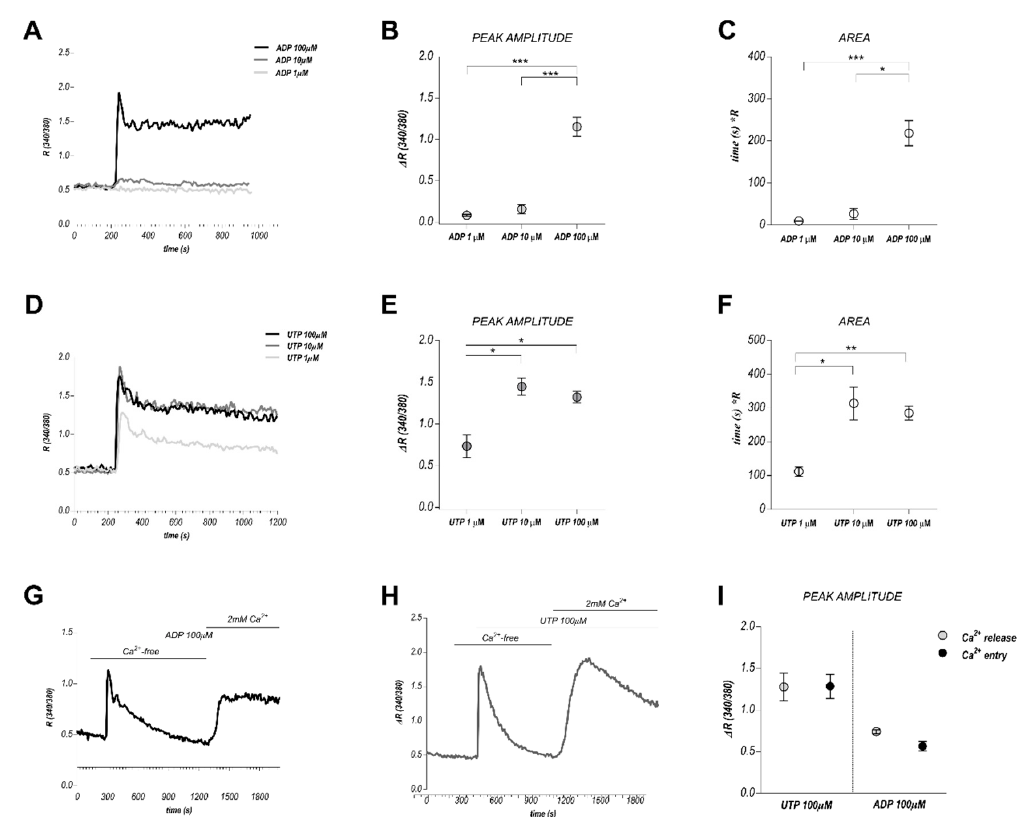
Figure 3. High eADP and eUTP stimulation triggers biphasic Ca 2+ signals in BTEC. ( A ) Representative traces of different Ca 2+ signals evoked by three different ADP concentrations (1, 10, 100 µM). ( B , C ) Quantification of the peak amplitude and area obtained upon 1, 10, 100 µM ADP stimulation. Area is calculated at 300 s from the beginning of the response. Data are expressed as mean ± SEM. * p -value < 0.05; ** p -value < 0.005 *** p -value < 0.0005. ( D – F ) The same for eUTP stimulation. ( G – I ) Representative average traces obtained from the application of the ‘Ca 2+ add-back’ protocol upon treatment with 100 µM ADP or 100 µM UTP and relative quantifications. Data are expressed as mean ± SEM.